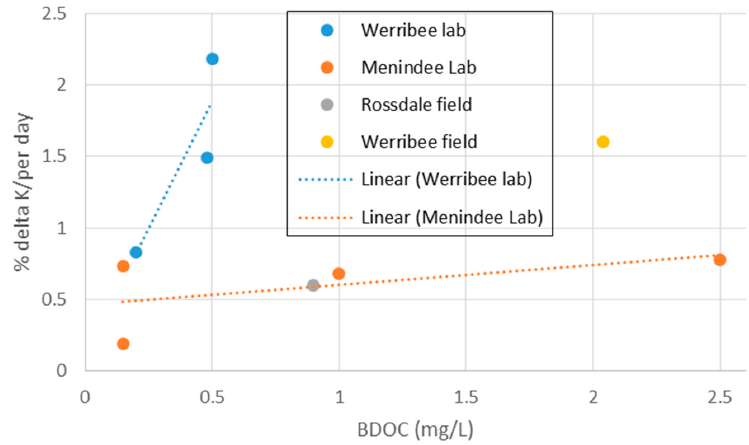
Figure 5. Summary of laboratory ‐ and field ‐ measured decline in hydraulic conductivity with respect to biodegradable organic carbon content of various types of waters in various siliceous aquifer materials (from Tables 5–7).